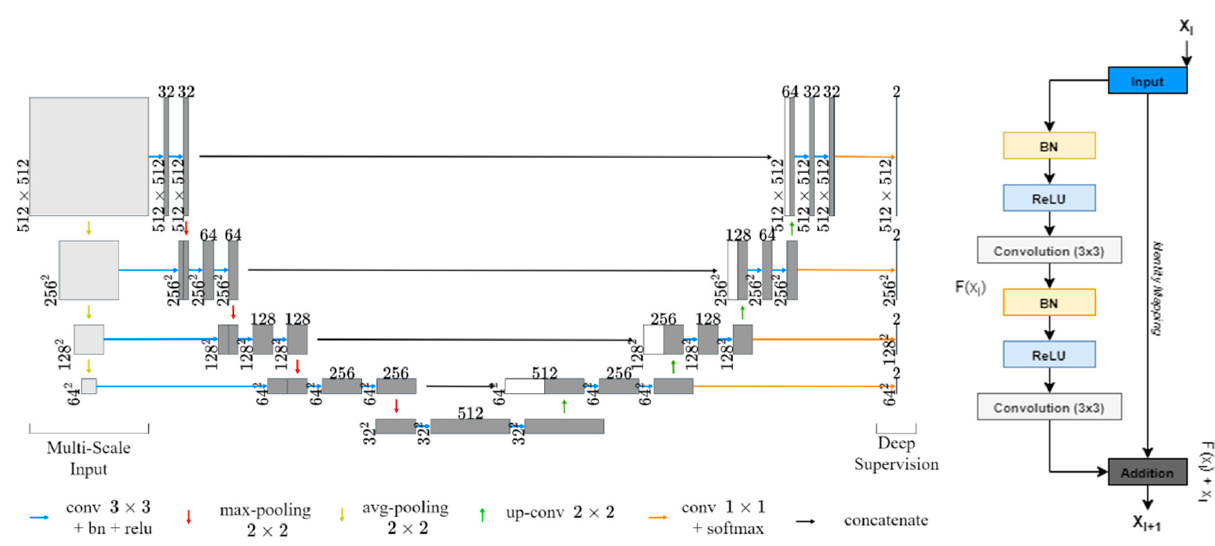
Figure 4. Network architecture for lung and image artifact segmentation: ( a ) visualizes our multiscale input residual U- architecture. ( b ) displays an example residual Net architecture. ( b ) displays an example residual block.